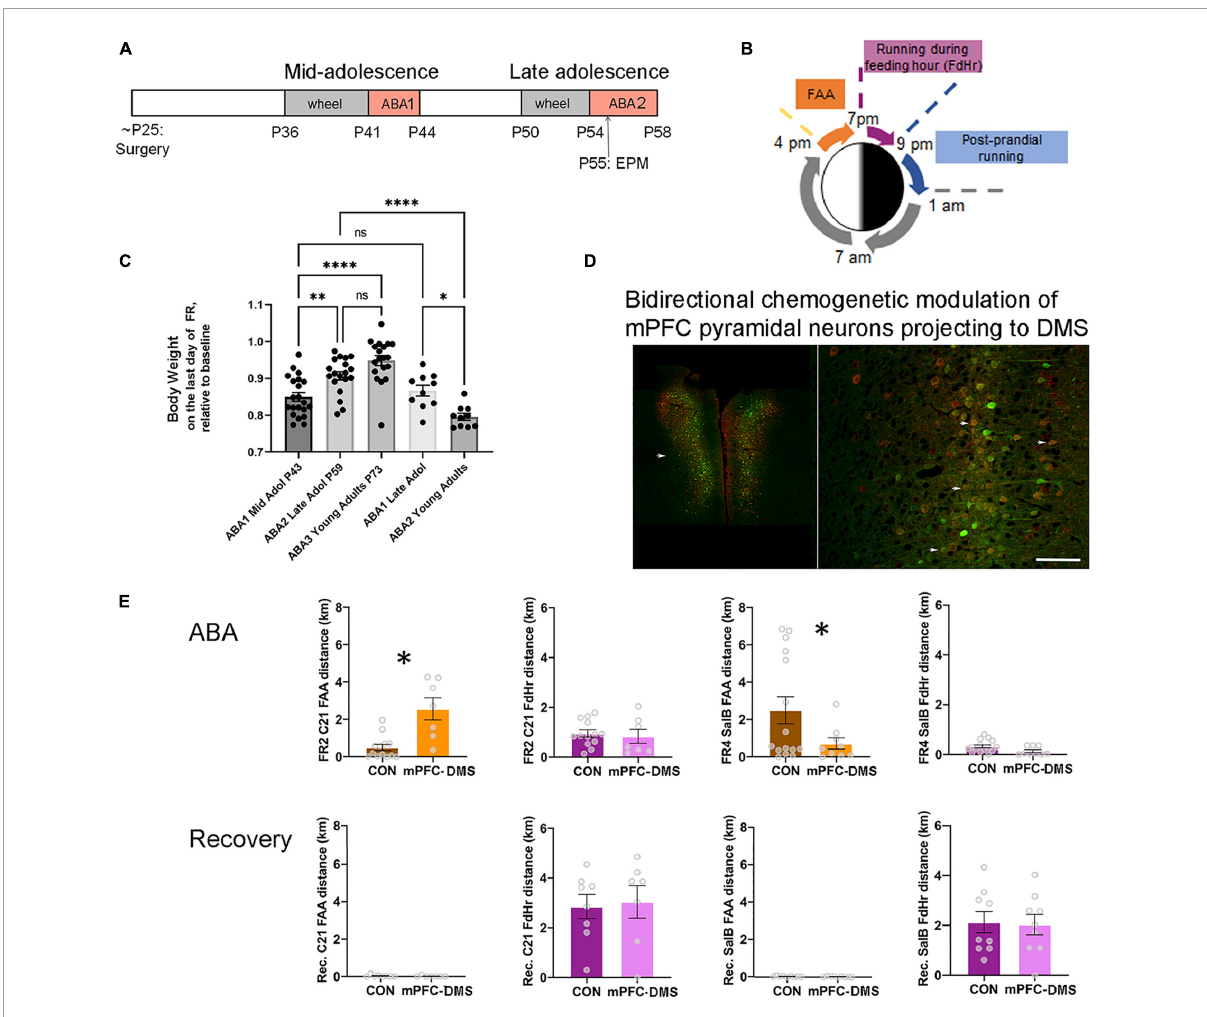
FIGURE1 The ABA (activity-based anorexia) paradigm used to reveal the contribution of pathway-specific E/I balance in mPFC to ABA vulnerability during adolescence. (A) Timeline. Animals undergo surgery for viral gene transfer to alter the E/I balance at the juvenile stage of ∼ P25. From this time, animals are reared in isolation. During mid-adolescence (P36-P44), animals acclimate to the wheel, then undergo 3 days of food restriction (FR) in the presence of a wheel (wheel + FR = ABA1), followed by a period of recovery without a wheel and with ad libitum food. In late adolescence (P50-58), animals undergo a second period of wheel acclimation and food restriction (ABA2). Animals are euthanized at the end of ABA2 or after weight restoration from the second ABA, under the condition of wheel access and no food restriction. Wheel running activity is monitored continuously whenever the wheel is in the cage. EPM = elevated plus maze, a test to measure anxiety-like behavior. (B) Segments of the 24 h during ABA. ABA begins at 1 pm by removal of food. Food availability becomes restricted to the hours of 7 pm (start of the dark cycle) to 9 pm. FAA develops within a day. (C) Comparisons of body weight retention of animals that have undergone their first ABA induction during mid-adolescence (ABA1), followed by two more cycles of ABA induction (ABA2, ABA3) versus those that underwent their first ABA induction during late adolescence, then of ABA2 in adulthood. Each data point represents the body weight datum of one animal. ∗ Indicates p = 0.0214; ∗∗ indicates p = 0.0055; ∗∗∗∗ indicates p < 0.0001. (D,E) Excitability of the cortico-striatal pathway is shown to underlie FAA of animals undergoing ABA2 but not of wheel running under the condition of ad libitum food availability during recovery from ABA2. (D) The fluorescent images are representative bilateral expression patterns of mCherry, the reporter protein of the excitatory Gq-DREADD and of mCitrine, the reporter protein for the inhibitory DREADD (KORD), by pyramidal neurons in the mPFC. Scale bar = 600 µ m (left) and 100 µ m (right). (E) Each data point in the bar graphs represents the distance run on the wheel during FAA or during the 2 h of food availability (FdHr) of one animal. On the second day of food restriction of ABA2 (FR2) and at the same hour during recovery following ABA2 (Recovery, Rec. bar graphs immediately below the FR2 graphs), C21 was injected intraperitoneally to activate excitatory Gq-M3-DREADDs expressed by mPFC pyramidal neurons projecting to dorsomedial striatum (DMS) (red cell bodies in the fluorescent image). On the fourth day of the second ABA (FR4) and another day during recovery from ABA2 (bar graphs immediately below those of FR4), salvinorin B (salB) was injected to activate the inhibitory DREADDs (KORD) expressed by the overlapping population of pyramidal neurons (Green). Bidirectional chemogenetic modulation of mPFC pyramidal neurons projecting to DMS revealed that activation of these neurons enhances FAA significantly, relative to control animals lacking DREADD expression, while suppression of the activity of these neurons suppresses FAA significantly, compared to the same control animals. The ligands were less efficacious in modulating wheel running during FdHr. Bar graphs represent mean ± SEM. Asterisks indicate p < 0.05 by unpaired t -test. Fluorescent images are modified from Figures 4A,B of Santiago et al. (2021), with permission to reuse from Oxford University